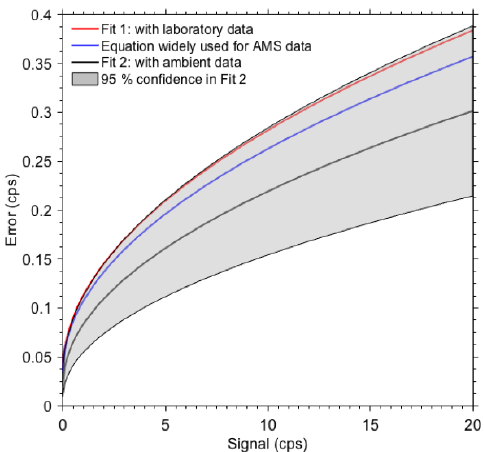
Figure 1. Error matrix estimation by fitting the error to the signal in- tensity. The red solid line is the best fitted curve from the laboratory experiment data, the blue curve denotes the fitting equation com- monly used for AMS data, and the black represents the fitting from the ambient data with a different method (see Supplement Sect. S2) with its fitting uncertainty (95% confidence) shown as the gray